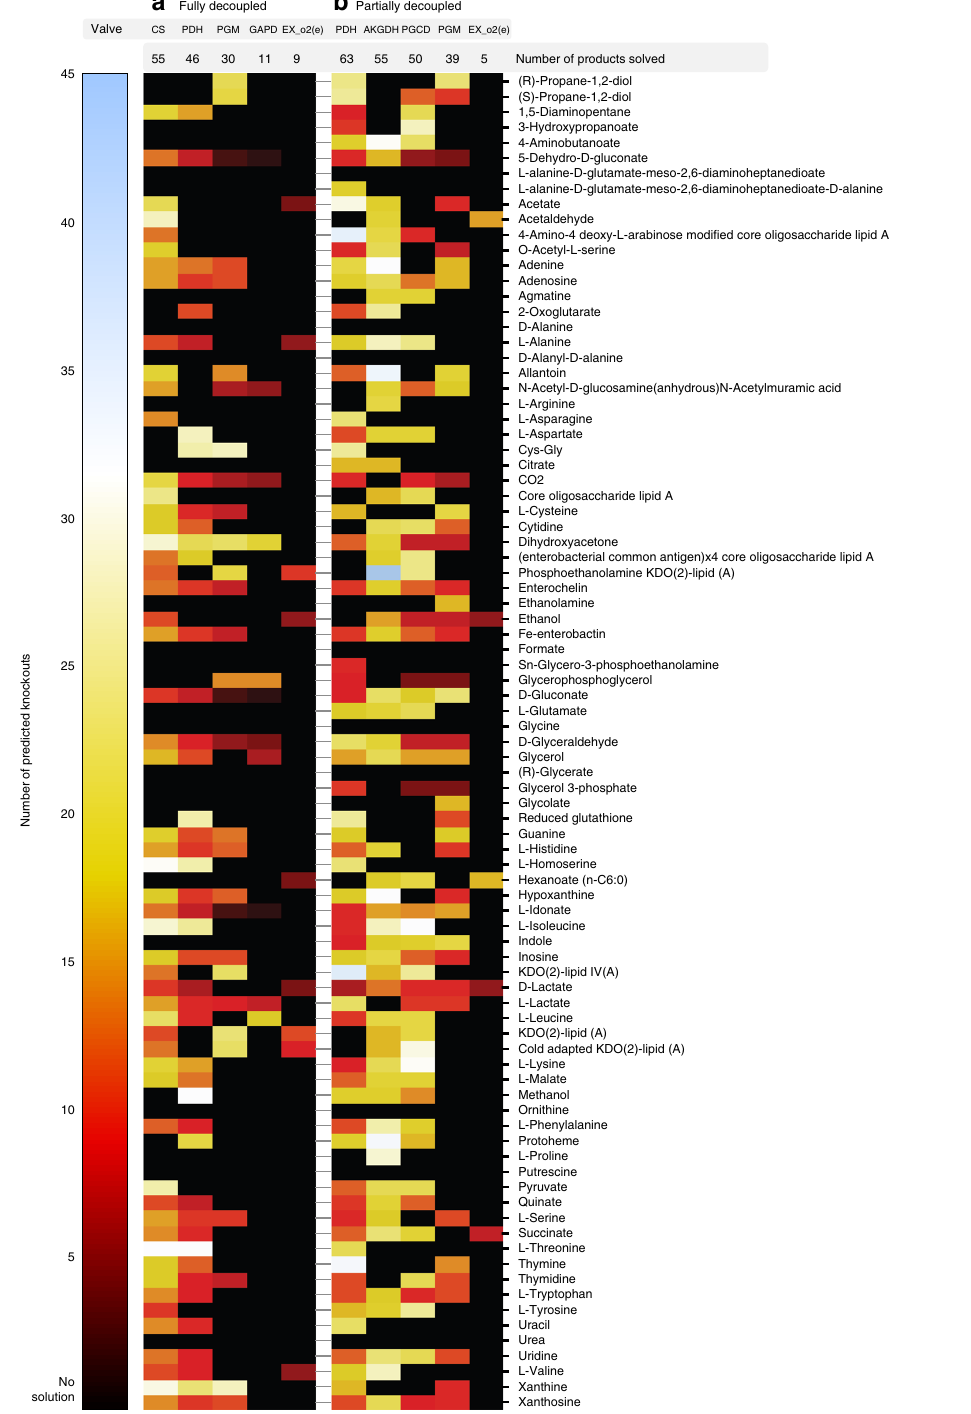
Fig. 5 Decoupling potential for top fi ve most frequently identi fi ed metabolic valves. Columns correspond to strategies employing speci fi ed metabolic valves. Rows correspond to speci fi c products. The color scale represents the number of knockouts in the identi fi ed strategy for each product and given valve, black indicates no solution was found. a Strategies for fully decoupled production. b Strategies for partially decoupled